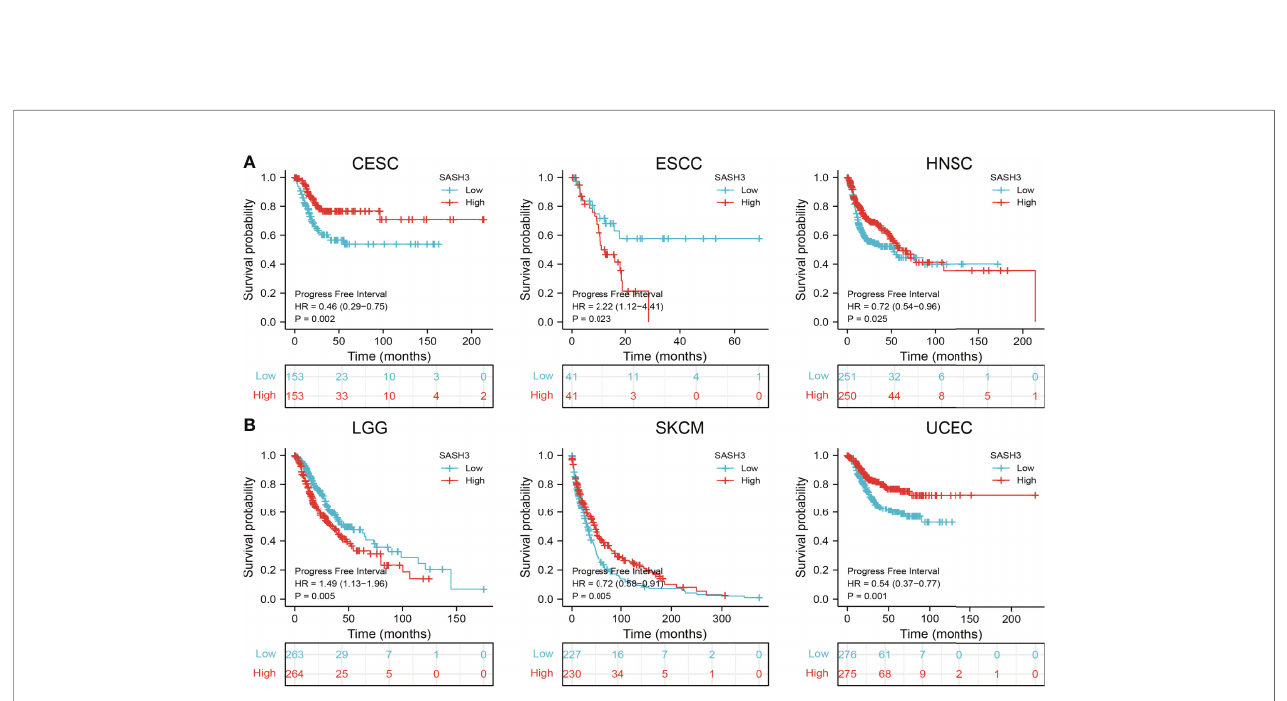
FIGURE 4 | SASH3 expression correlated with the disease-free survival of pan-cancer. (A) The disease-free survival for SASH3 in CESC, ESCC, and HNSC. (B) The disease-free survival for SASH3 in LGG, SKCM, and